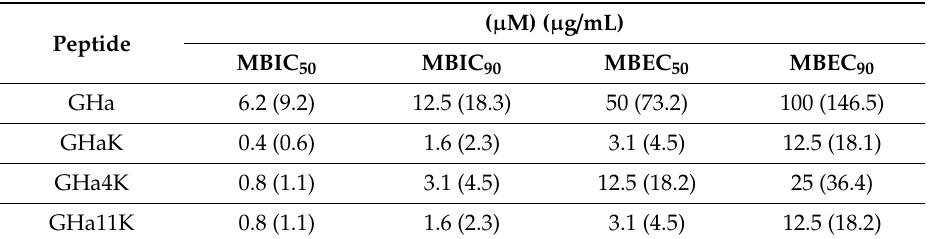
Table 3. The antibiofilm activity of peptides against S. aureus .